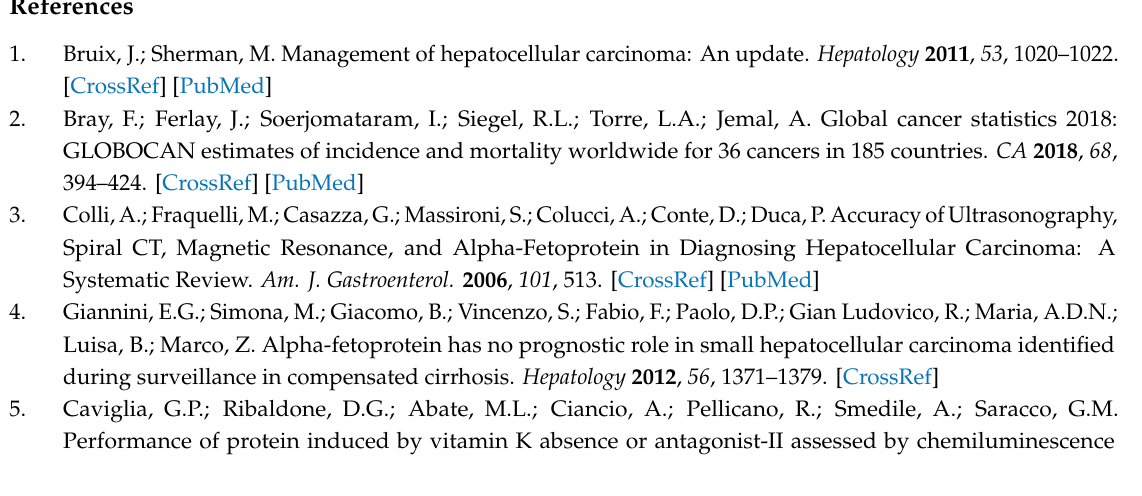
Table S1: clinicopathological characteristics of the 20 HCC